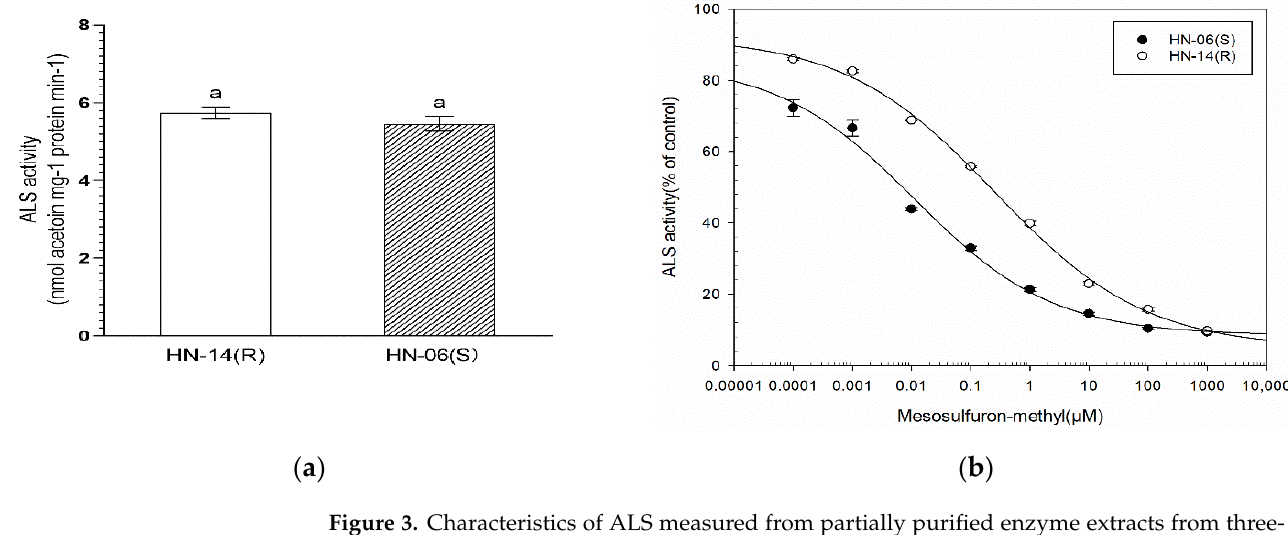
Figure 3. Characteristics of ALS measured from partially purified enzyme extracts from three- to four-leaf-stage ALS-herbicide-susceptible (ALS wild type), and ALS-resistant (574-Leu) black-grass plants. ( a ) Extractable total activity of R and S plants in vitro ALS. ( b ) Inhibition assay of ALS isolated from the R and S black-grass by mesosulfuron-methyl. Different letters indicate significant differences in mean estimates according to Dunnett’s test (α = 0 .05).